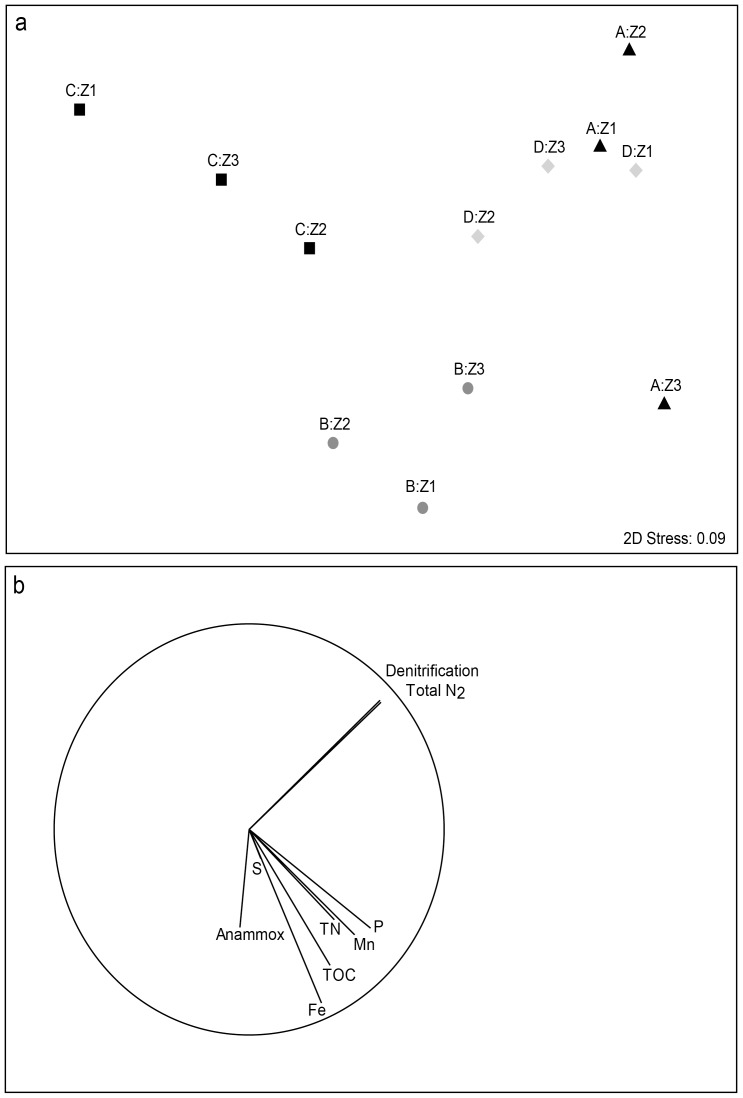
Similarity between N2 production rates and sediment characteristics in the four settlement ponds.a) nMDS ordination; 2-D stress = 0.09. b) The same nMDS as a), with vectors superimposed, the length and direction of which indicated the strength of the correlation and direction of change between the two nMDS axes.